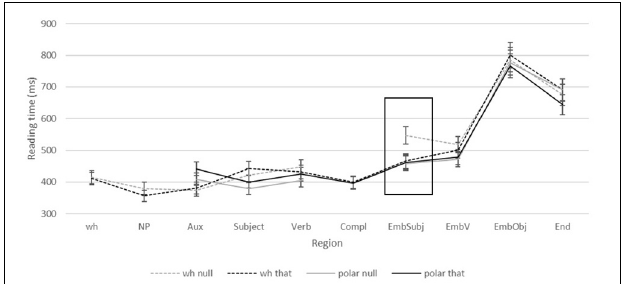
FIGURE 1 | Mean reading times for each region of the wh question, by condition. The primary region of interest (the embedded subject position) is indicated with a box. Error bars show 95% Confidence